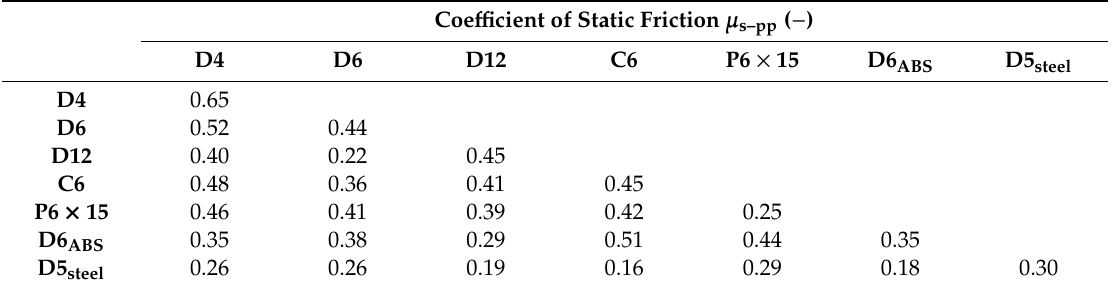
Table A5. Coe ffi cient values of contact static friction (particle-particle).